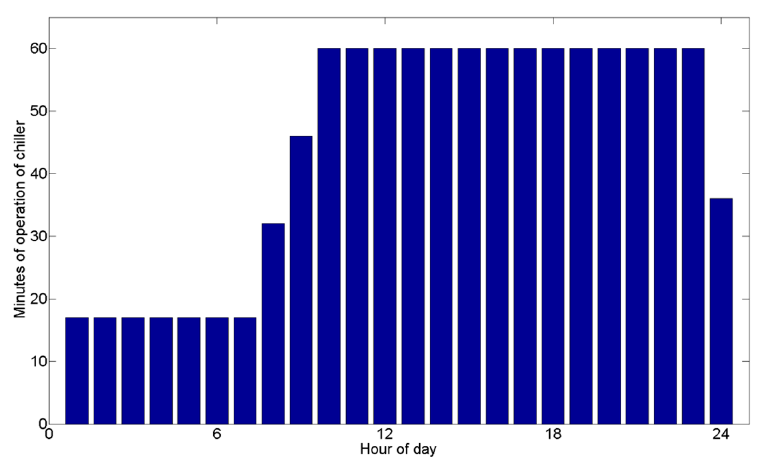
Figure 8. Minutes of operation of the chiller.